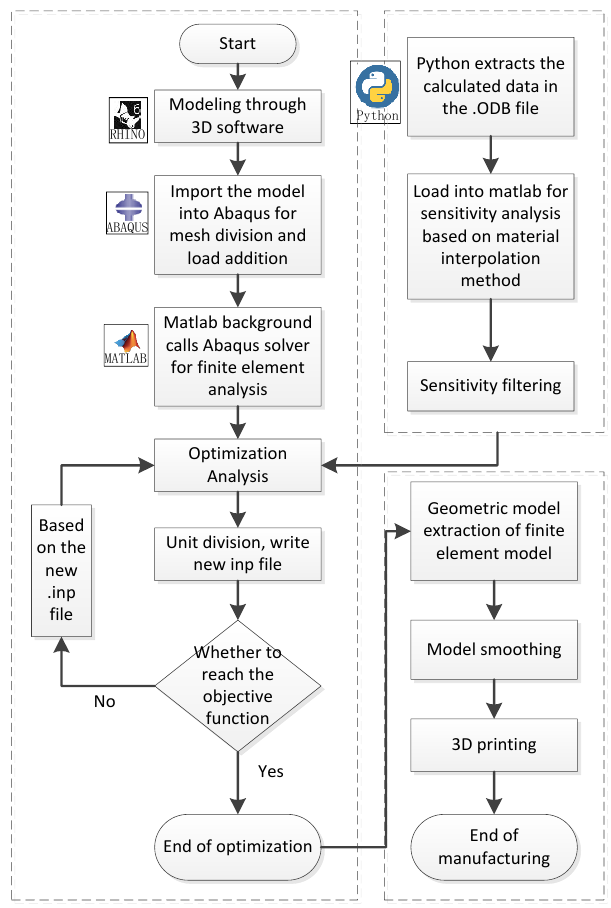
Figure 2. Optimization-manufacturing software integration method flow chart.